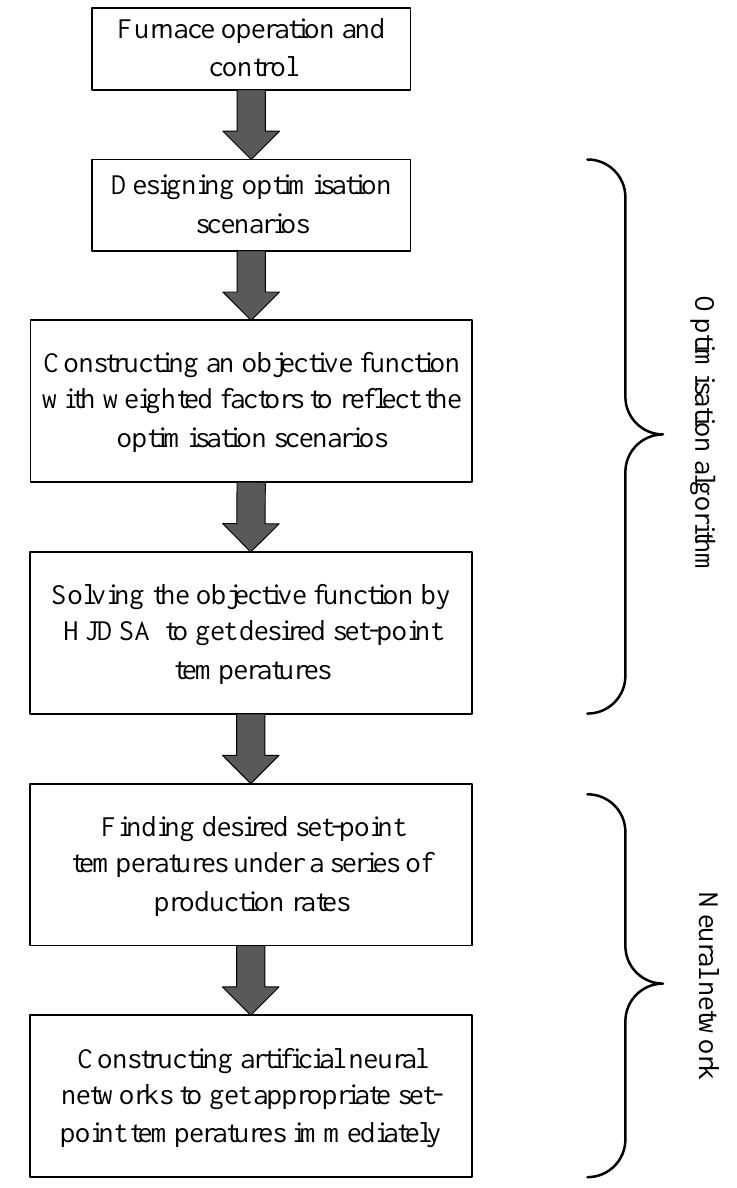
Figure 1 . The steps of proposed method in this paper. Figure 1. The steps of proposed method in this